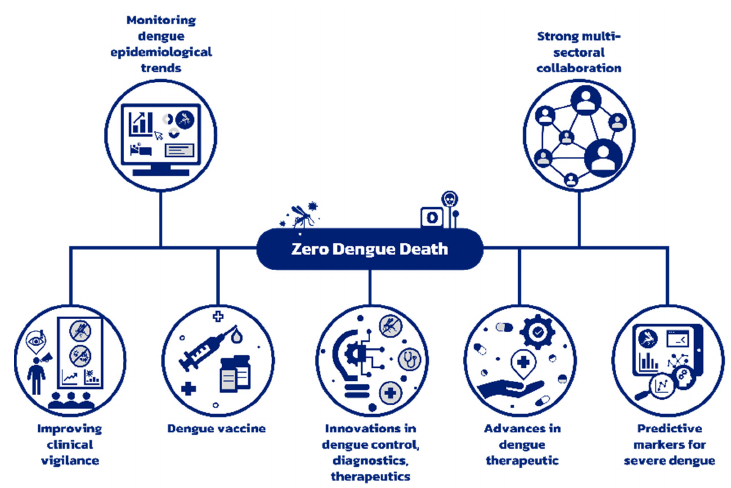
Figure 1. Strategy to reduce preventable dengue deaths to zero.